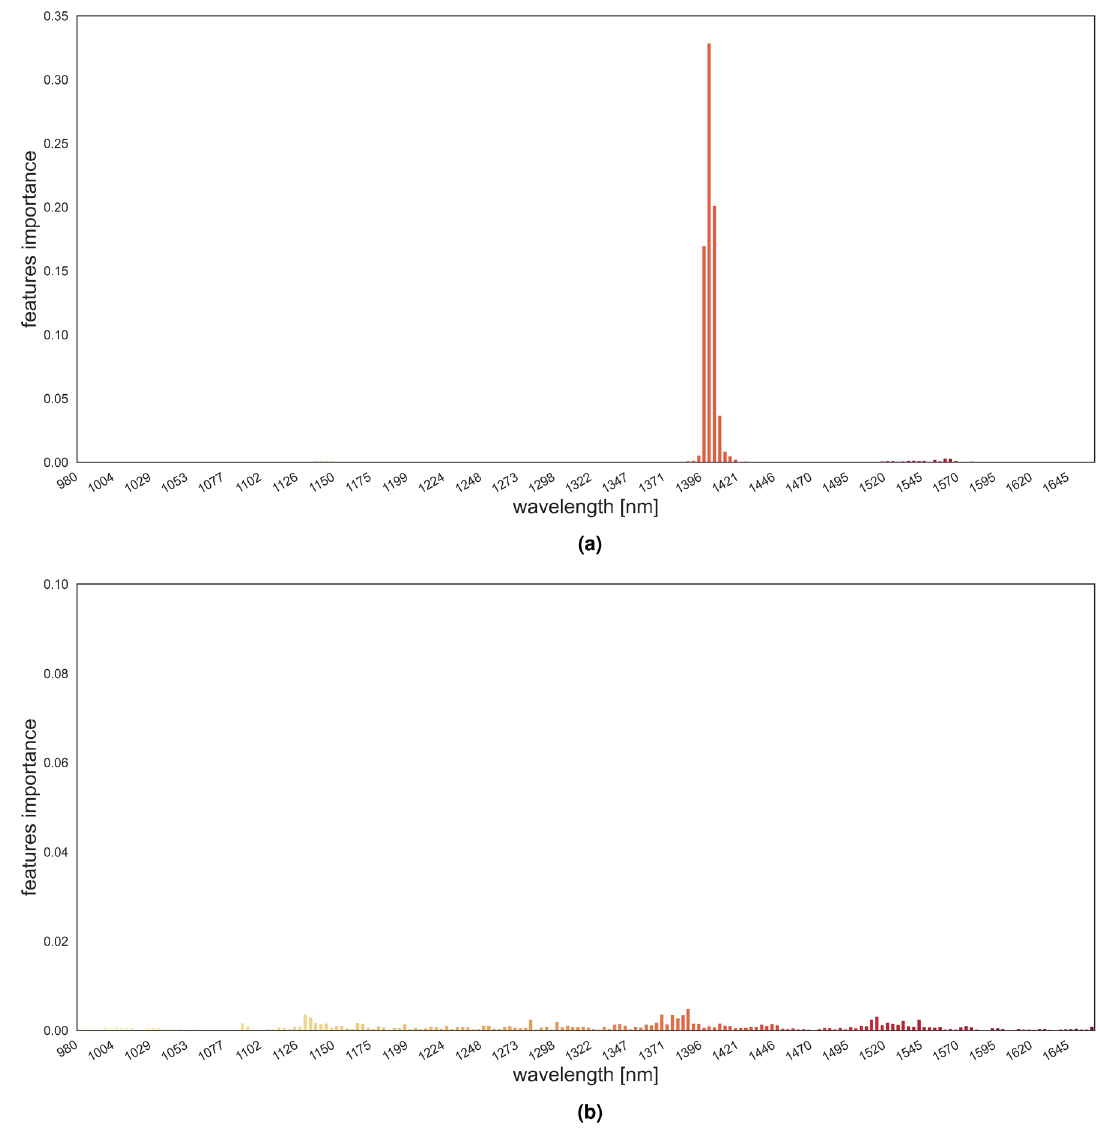
Figure 12. Hyperspectral wavelengths importance: ( a ) features corresponding to the mean values, ( b ) features corresponding to the standard deviation